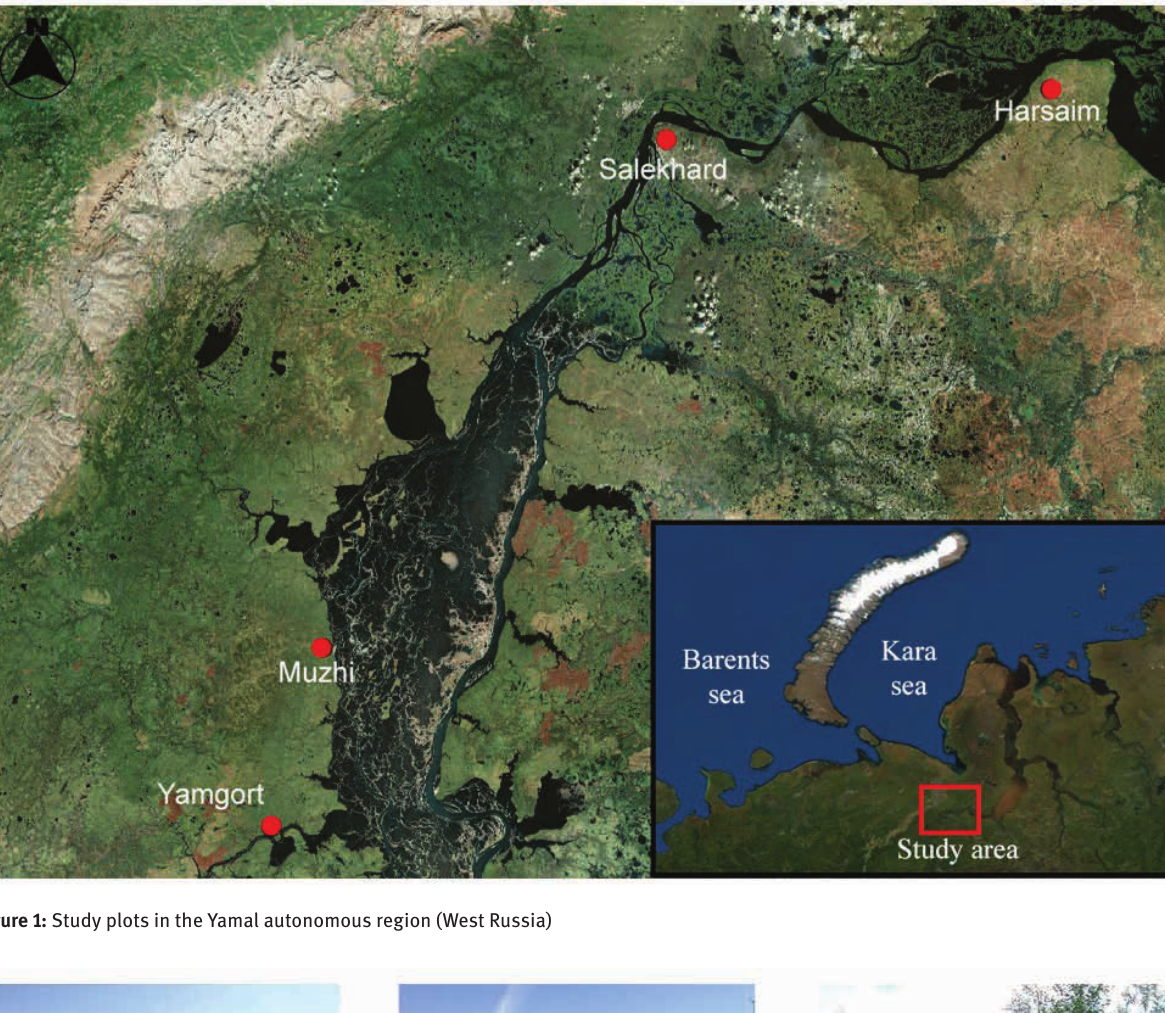
Figure 1: Study plots in the Yamal autonomous region (West Russia)